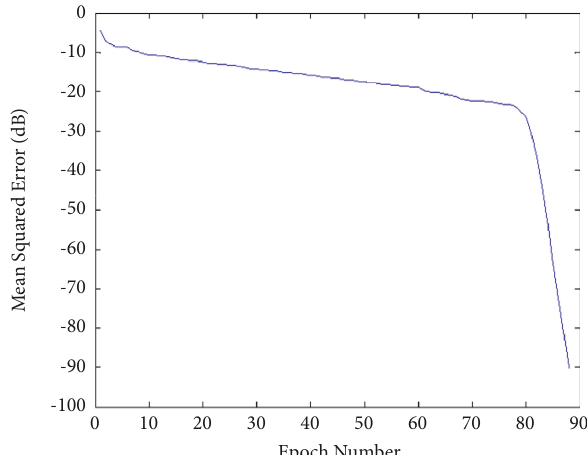
Figure 4: Learning curve for the 3-set classification neural network.